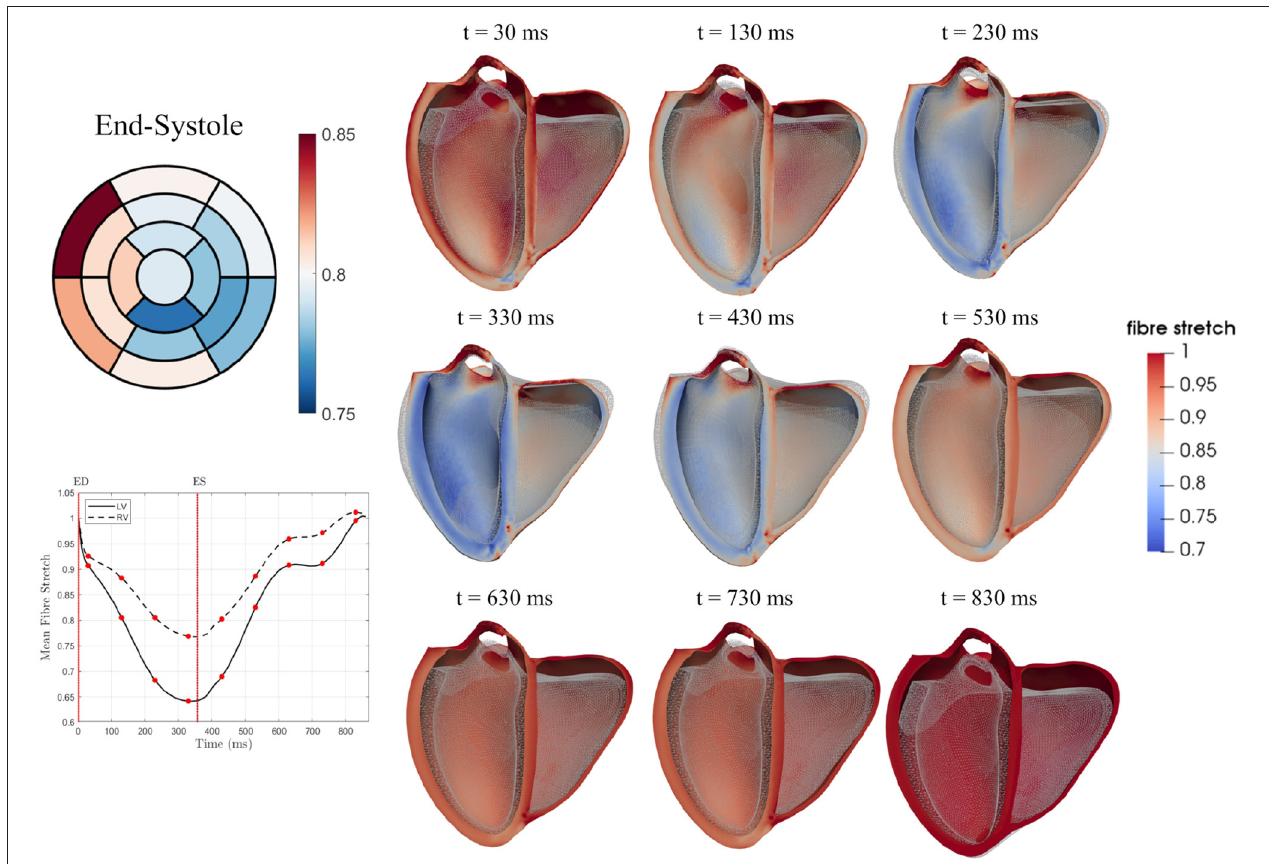
FIGURE 8 | Mean fibre stretch over the cardiac cycle is shown for both the LV and RV for a single case (v1). Fibre stretch over the cardiac cycle is also plotted for nine time points with the reference state model (ES) shown as a wireframe mesh. The bullseye plot illustrates differences in regional stretch at the end-systolic state in the 17 AHA